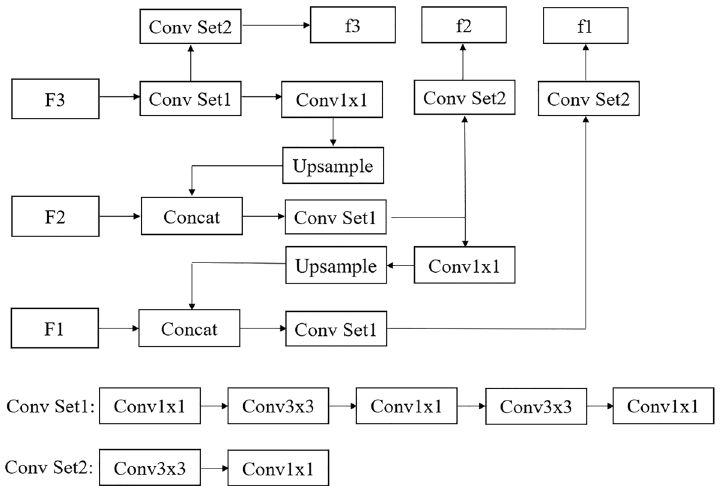
Figure 2. The network of multiscale feature extraction.